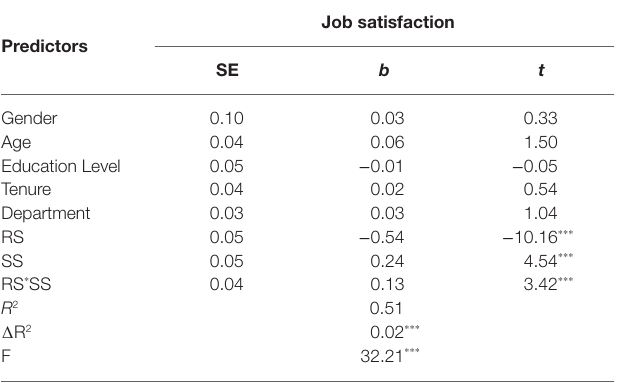
TABLE 6 | Moderated regression analysis.